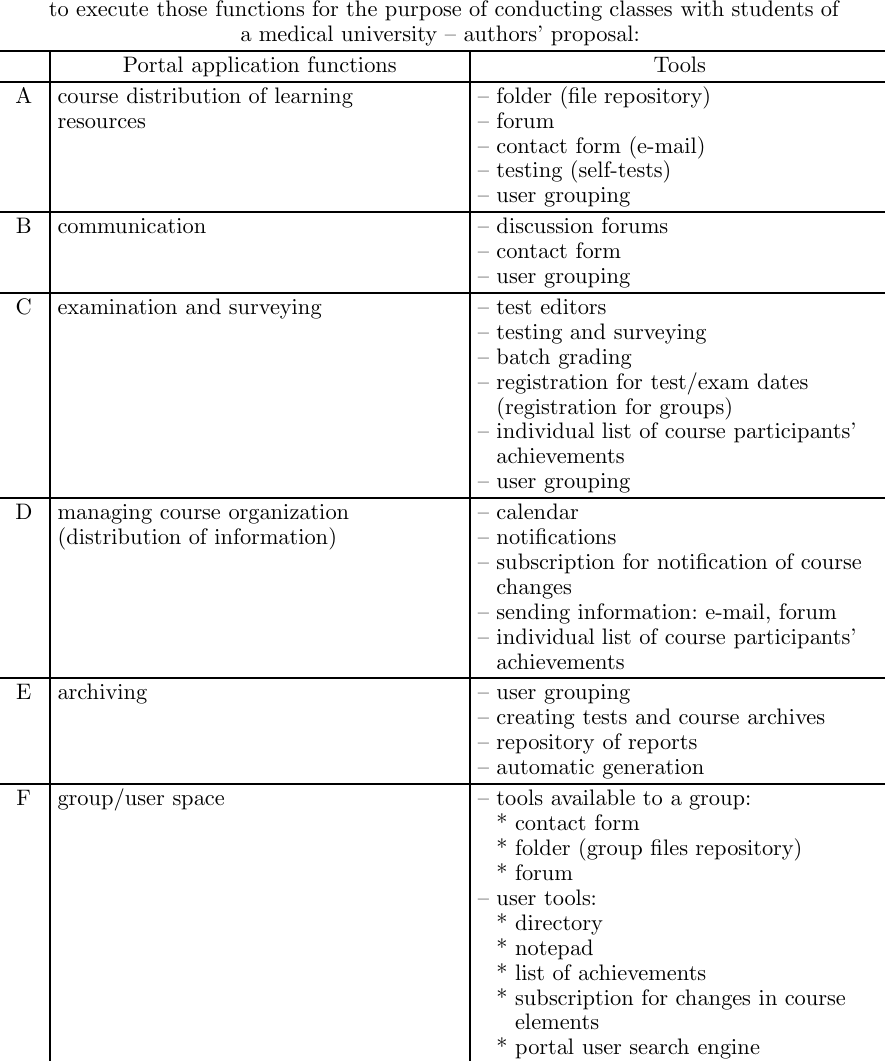
Table 1. E-learning portal tools for medical education – authors’ proposal Division of portal application functions and a set of necessary e-learning portal tools to execute those functions for the purpose of conducting classes with students